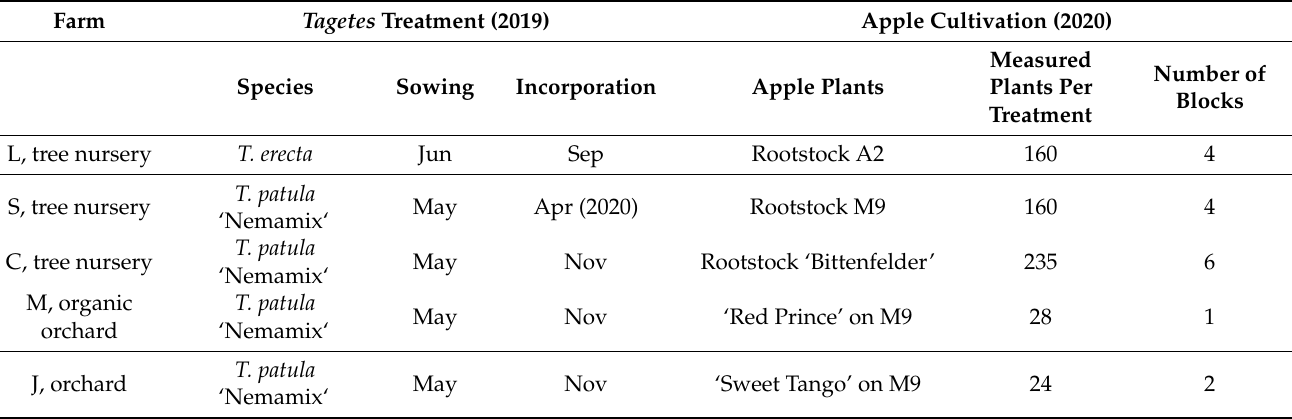
Table 1. Experimental details of field trials in companies.